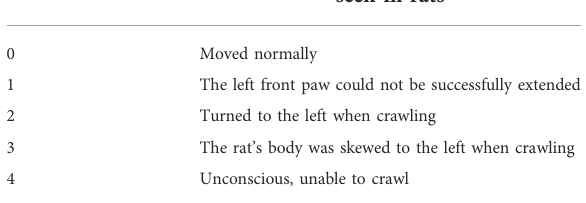
TABLE 2 Neurological function